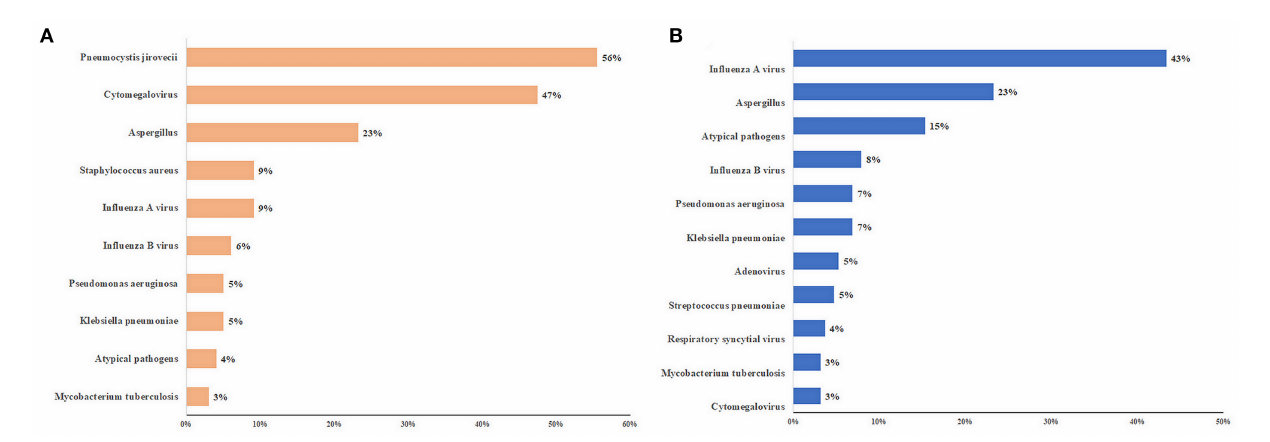
FIGURE1 Top 10 pathogens of patients with severe community-acquired pneumonia. (A) immunocompromised patients; (B) immunocompetent patients. The length of the colored bars and numbers behind them indicate the proportion of each pathogen, calculated using their positive number as the numerator and the number of patients with positive pathogen results as the denominator.